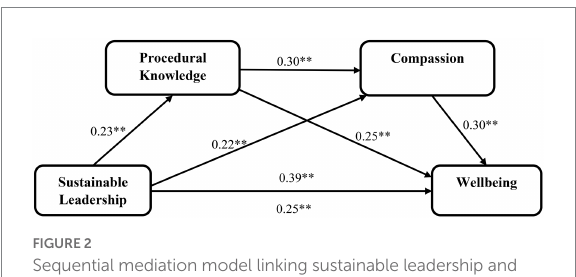
FIGURE 2 Sequential mediation model linking sustainable leadership and